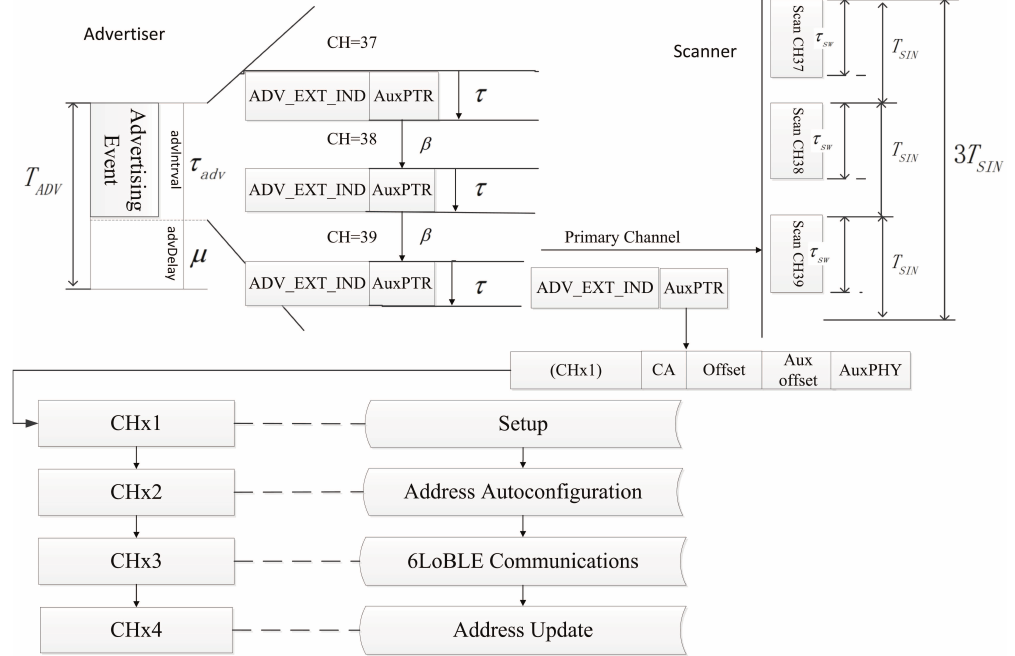
Figure 3. Neighbor discovery for IPv6 over Bluetooth Low Energy Mesh Network.